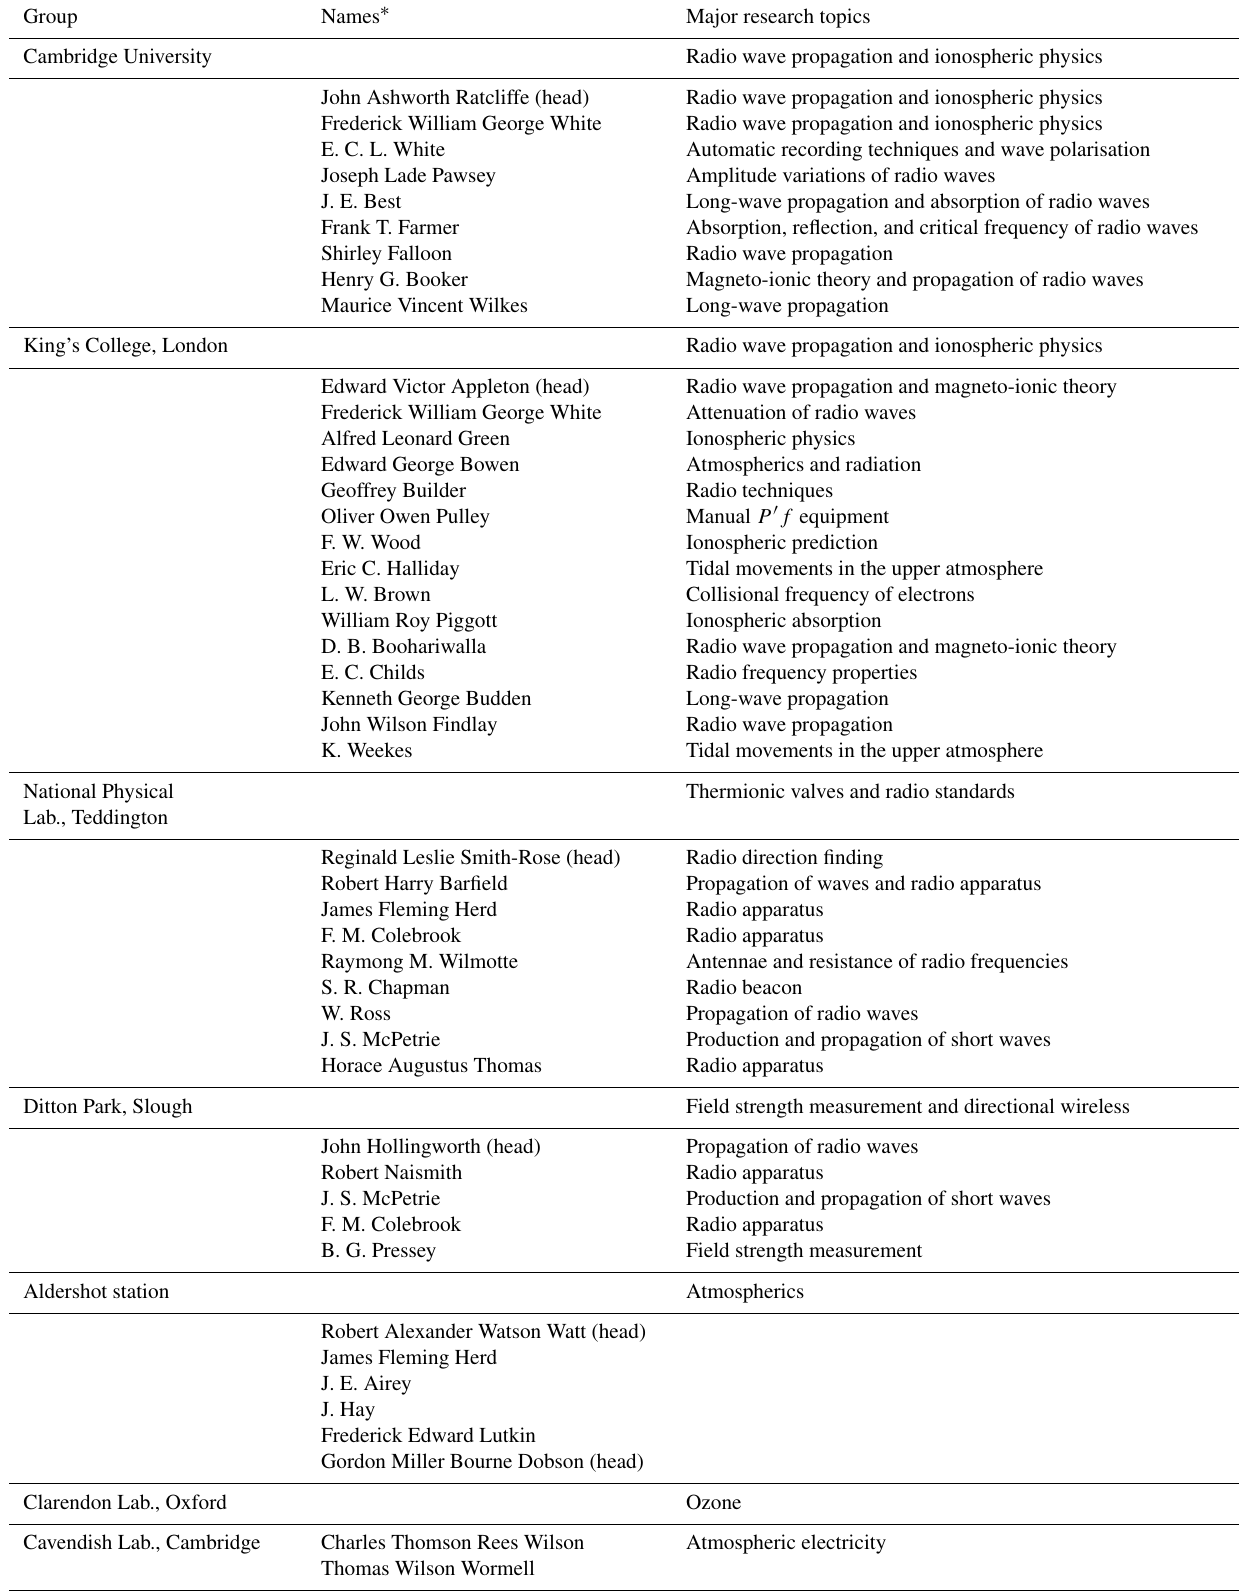
Table 1. Ionospheric physics in Britain in the interwar years. Groups and major research topics.